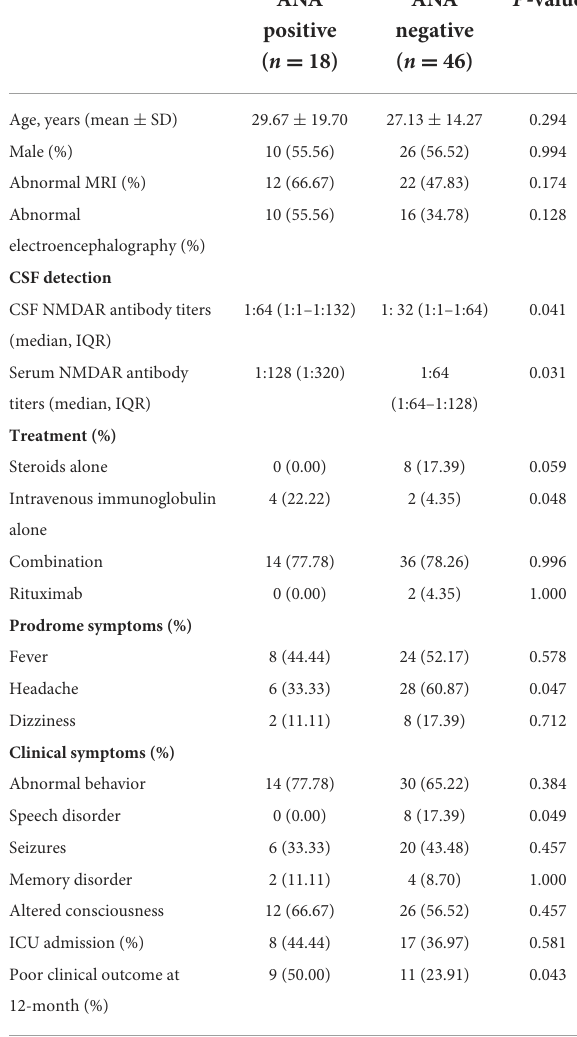
TABLE 2 The clinical characteristic and clinical outcomes between ANA positive and ANA negative in anti-NMDAR encephalitis. ANA positive ( n = 18)